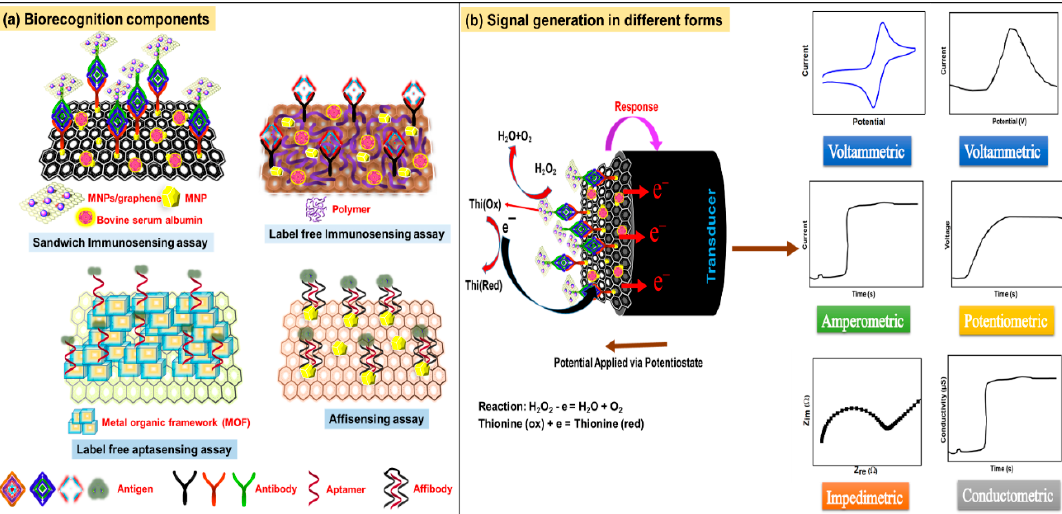
Figure 4. Simplified illustration of different biorecognition components designed based on sandwich, label-free immunosensing assay, aptasensing assay and affisensing assay ( a ) and the process of signal generation and different electroanalytical techniques used for ECBs ( b ).